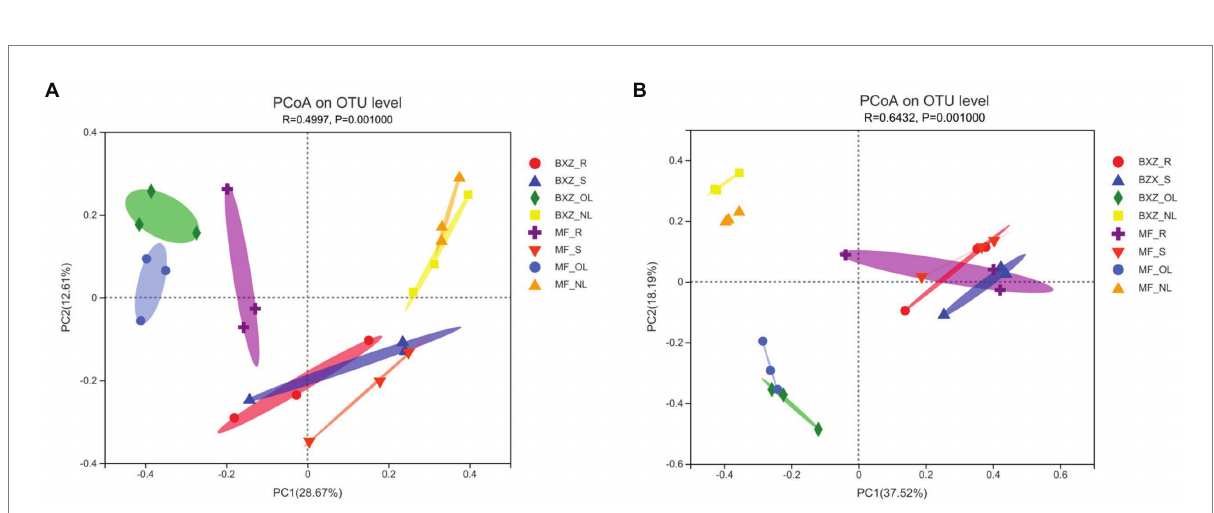
FIGURE 2 PCoA analysis of community structures of endophytic bacteria (A) and fungi (B) in tea trees. BXZ_R, BXZ_S, BXZ_OL and BXZ_NL represented root, stem, old leave and new leave samples of BXZ cultivar., while MF_R, MF_S, MF_OL and MF_NL represented root, stem, old leave and new leave samples for MF